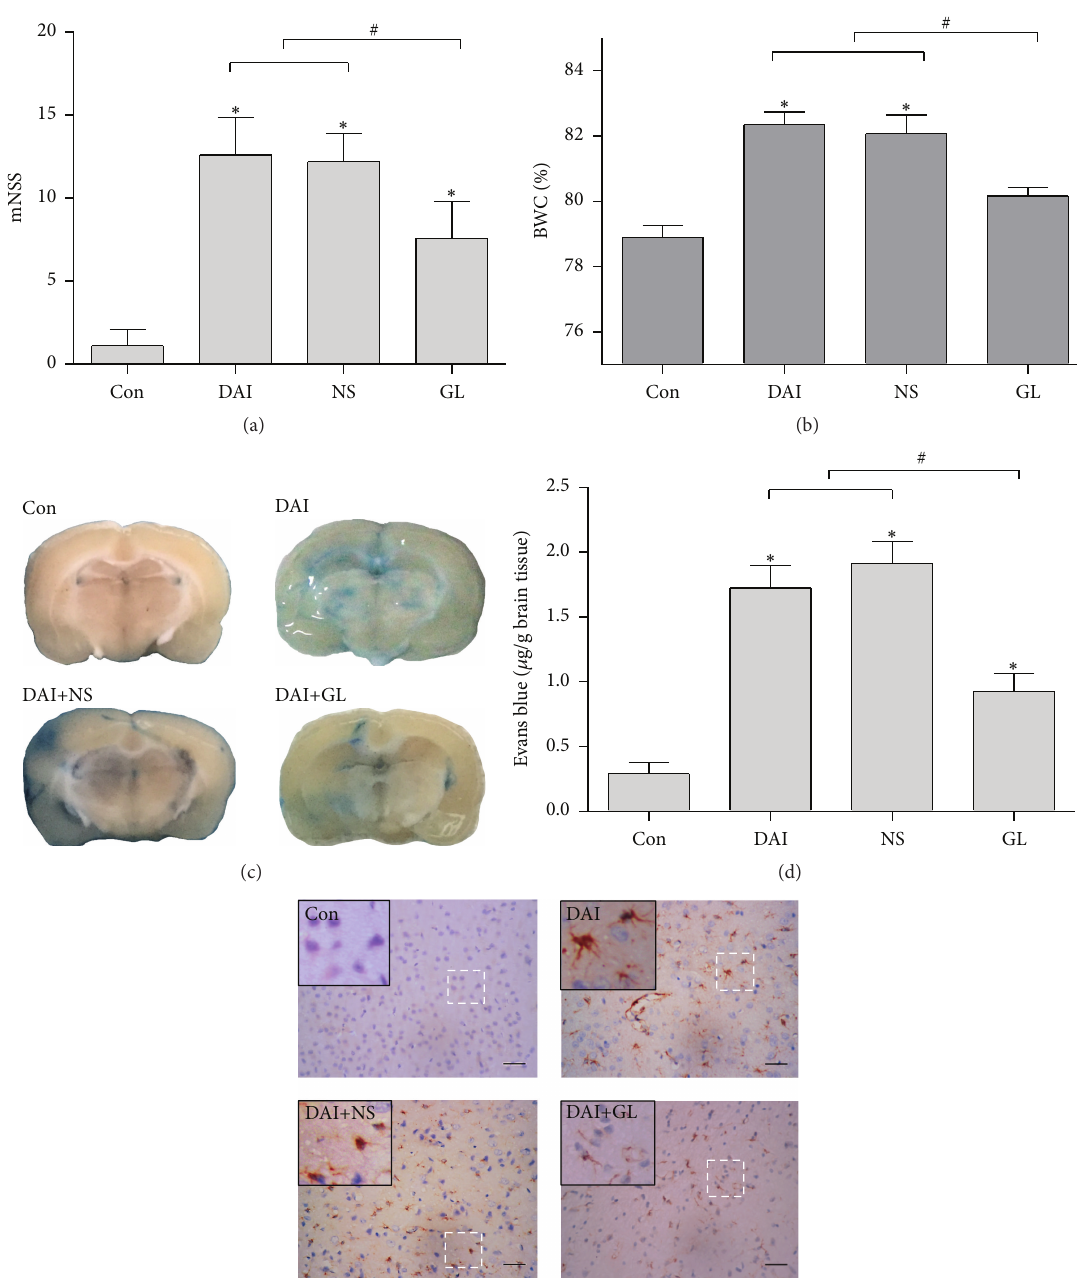
Figure 4: Inhibition of HMGB1 decreased brain edema, prevented the disruption of BBB, alleviated axonal injury, and improved the neurological deficits. Pretreatment with GL significantly improved the neurological outcomes compared with saline pretreatment after DAI (a). Brain edema evaluation showed that BWC in DAI + GL group was significantly reduced compared with DAI + NS group (b). The general observation of Evans blue in rat brains after DAI in different groups (c). The quantitative analysis showed that the Evans blue level in DAI + GL group was much lower compared with DAI + NS group, although still above the control level (d). Protective effect of GL on the axonal injury after DAI as demonstrated by the immunohistochemical staining of 𝛽 -APP. Pretreatment with GL dramatically reduced the accumulation of 𝛽 -APP compared with saline pretreatment group, which indicated a reduced structural axonal injury after DAI (e). ∗ 𝑝 < 0.05 compared with control group; # 𝑝 < 0.05 compared with DAI + saline